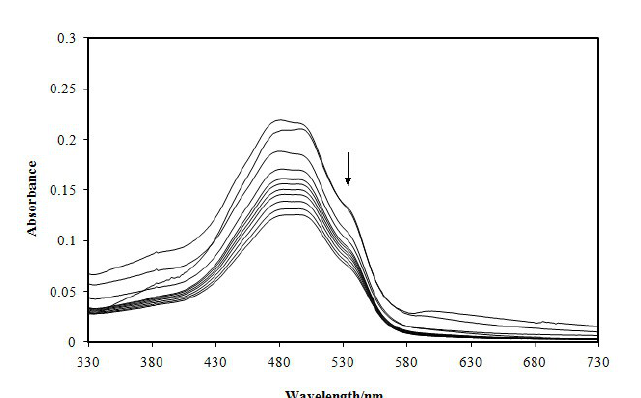
Figure 2. Absorption spectra of EPR in the presence of DNA at different concentrations. ＝ 0.0, 6.5, 12.5, 18.0, 23.0, 27.6, 33.2, 35.8, 39.5, 42.9 and 46.0 μmol L -1 for curves 1- C DNA ＝ 10.0 μmol L -1 in phosphate buffer (0.1 mol L -1 , pH 11, and C EPR